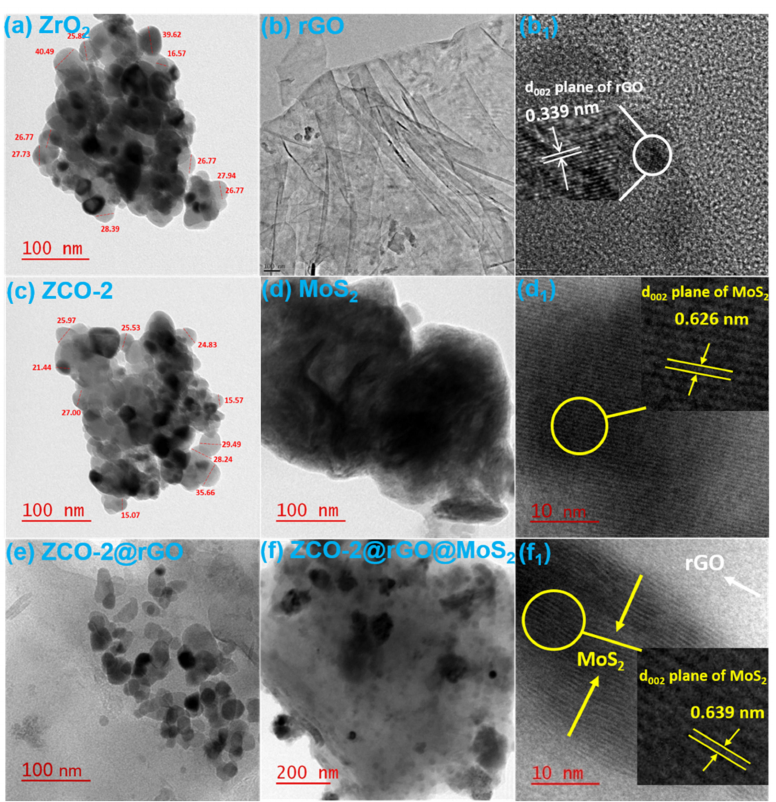
Figure 3. Transmission electron microscopy (TEM) images of ( a ) ZrO 2 , ( b ) rGO, ( c ) ZCO-2, ( d ) MoS 2,